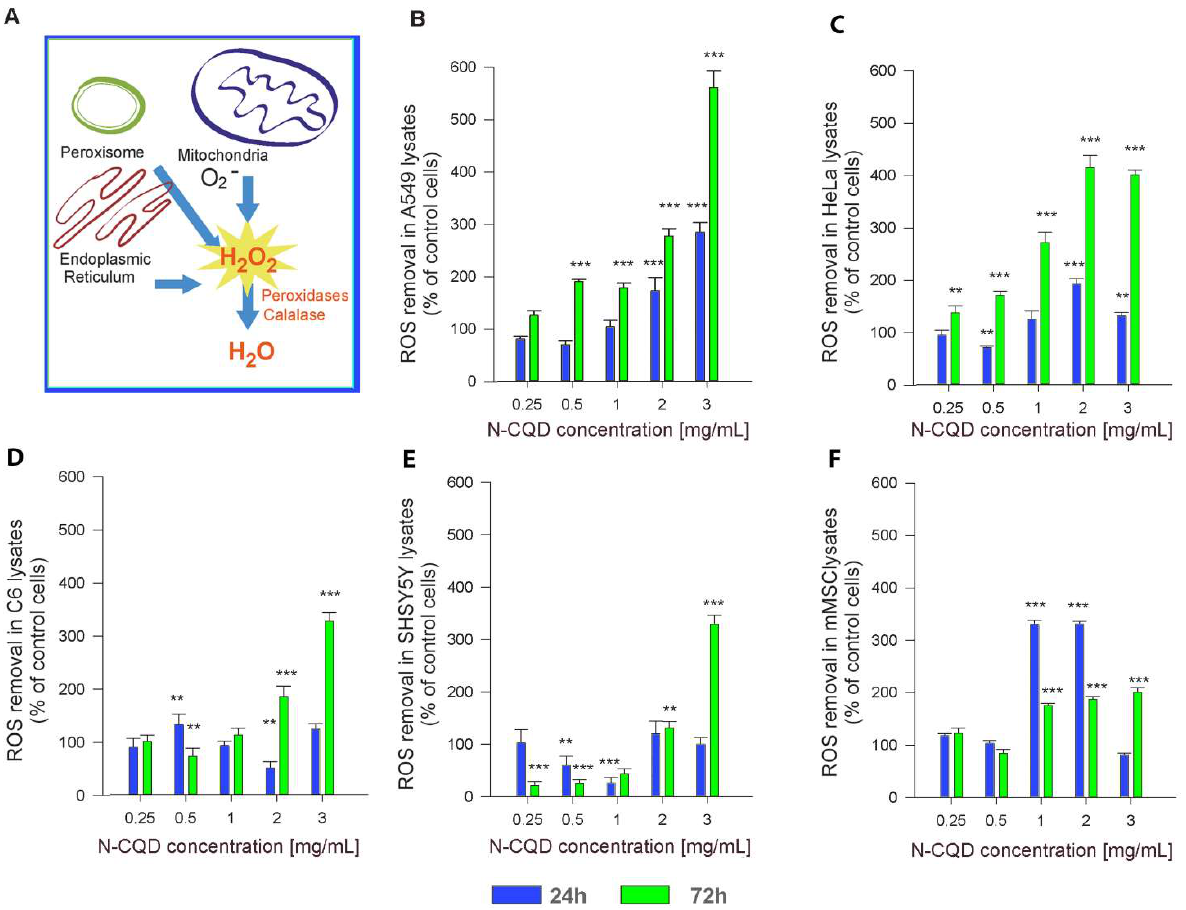
Figure 4. ROS removal ability in N-CQD-treated cell lysates with reference to control cells (without N-CQD): ( A ) schematic representation of ROS generation and removal inside the cells, ( B ) A549, ( C ) HeLa, ( D ) C6, ( E ) SH-SY5Y, ( F ) mMSC. All results are colored by culture time: 24 h (blue) and 72 h (green). The statistical significance of the differences is related to control samples and marked on the graphs with asterisks (* for p ≤ 0.05, ** for p ≤ 0.01, *** for p ≤